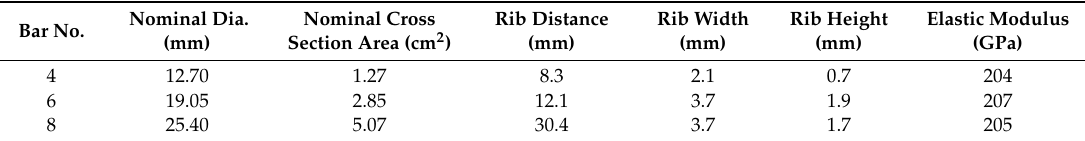
Table 3. Basic properties of